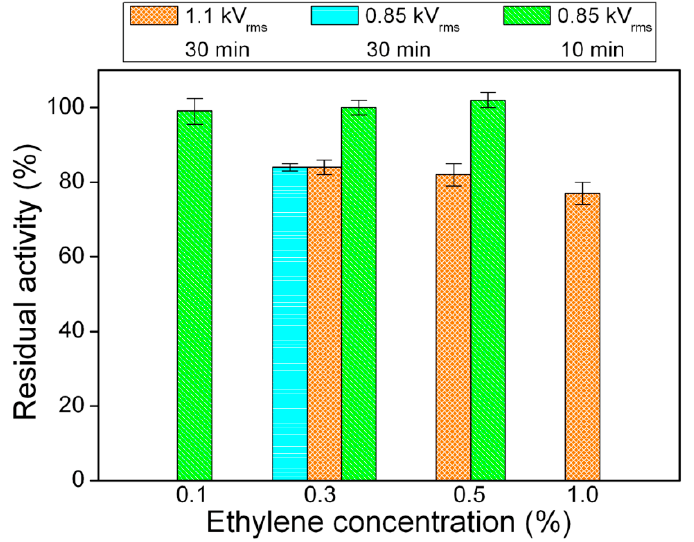
Figure 7. Residual activity of Tyr (5 μ g) after exposure to He/C 2 H 4 fed DBDs under different processing conditions (V a = 0.85, 1.1 kV rms ; [C 2 H 4 ] = 0.1, 0.3, 0.5, 1%; t = 10, 30 min).